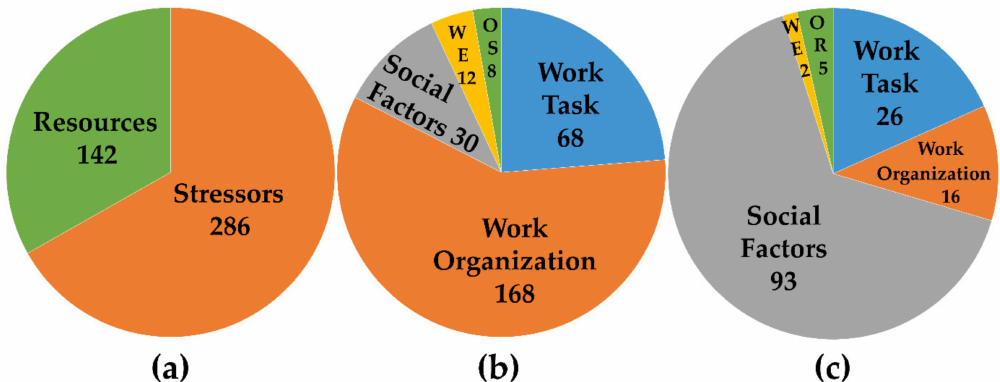
Figure 1. Graphical representation based on Tables A2 and A3 of the number of mentioned resources or stressors across all occupational groups ( a ), the number of mentioned stressors per work